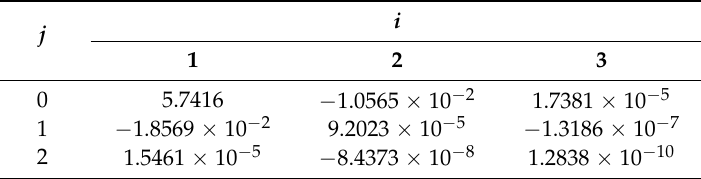
Table 2. Polynomial coefficient b ij of heat